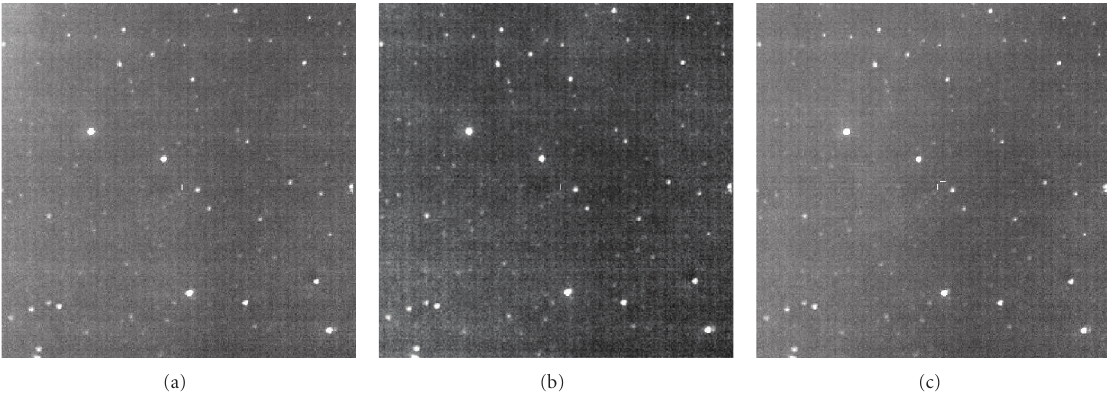
Figure 16: A 6 ◦ × 6 ◦ field around the GRB090424 Swift XRT position. One-minute exposure images taken before, during, and after T GRB . Clouds can be seen on the images, resulting in the optical limit of V < 9 . 7 m on each frame. Animation is available here: http://observ.pereplet.ru/images/film